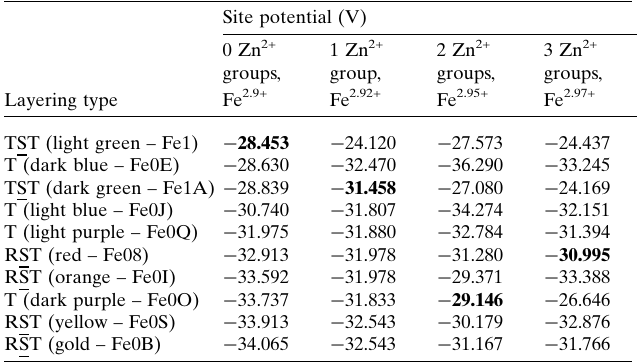
Table 8 Site potentials for each of the symmetry-related tetrahedral groups in the (34) 3 hexaferrite. Each group is identified by its colour from Fig. 12( b ) and site label in the CIF of the refined structure. The potentials have been averaged over the six tetrahedral sites in each group. In each column, the Fe layer with the least negative site potential is highlighted in